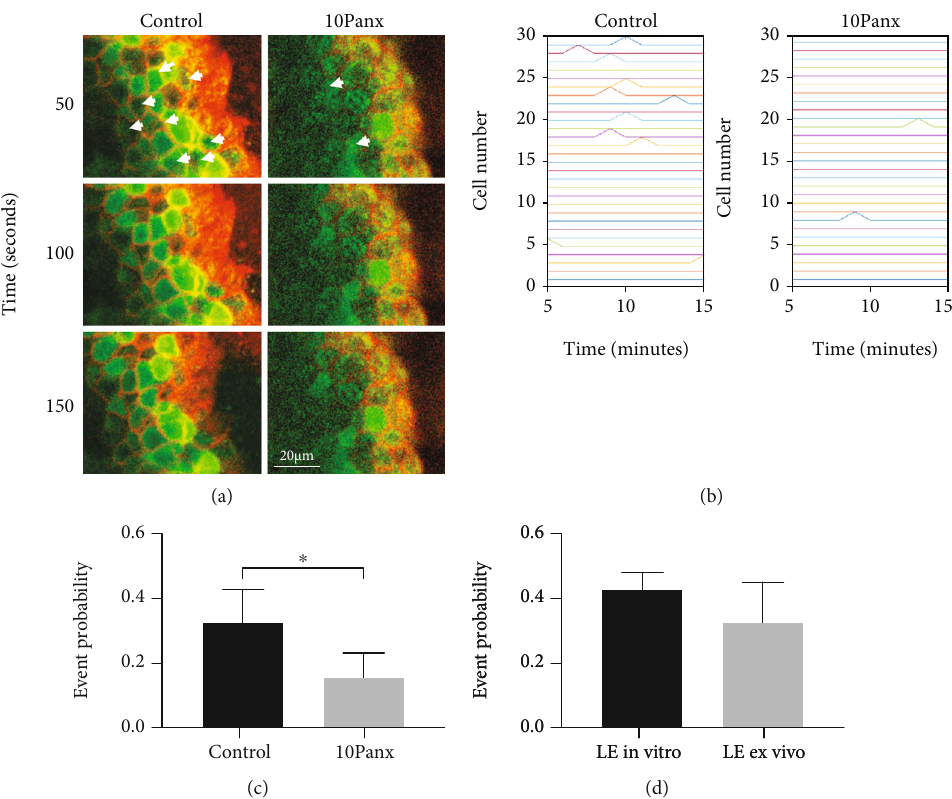
Figure 3: Pannexin1 mediates communication between corneal epithelial cells. (a) Representative images of B6 control corneas incubated in the presence of 10Panx or a scrambled control (control) peptide and then labelled with Cal-520 AM and CellMask Deep Red for imaging. Representative images of the Ca 2+ wave in basal epithelial cells after injury: 50, 100, and 150 seconds. Arrowheads mark cells to follow over time. (b) MATLAB event charts showing the Ca 2+ mobilization events detected over time. (c) Event probability values comparing corneas preincubated in the presence of either 10Panx or scrambled control (control) peptide followed by an epithelial scratch injury. (d) Event probability values comparing the wound response near the leading edge of the corneal epithelium ex vivo to in vitro following a scratch wound. Data are expressed as mean ± SEM and were analyzed with a one-way ANOVA with the Tukey ’ s multiple comparison test. p < 0 : 05 . N is a minimum of 3 independent